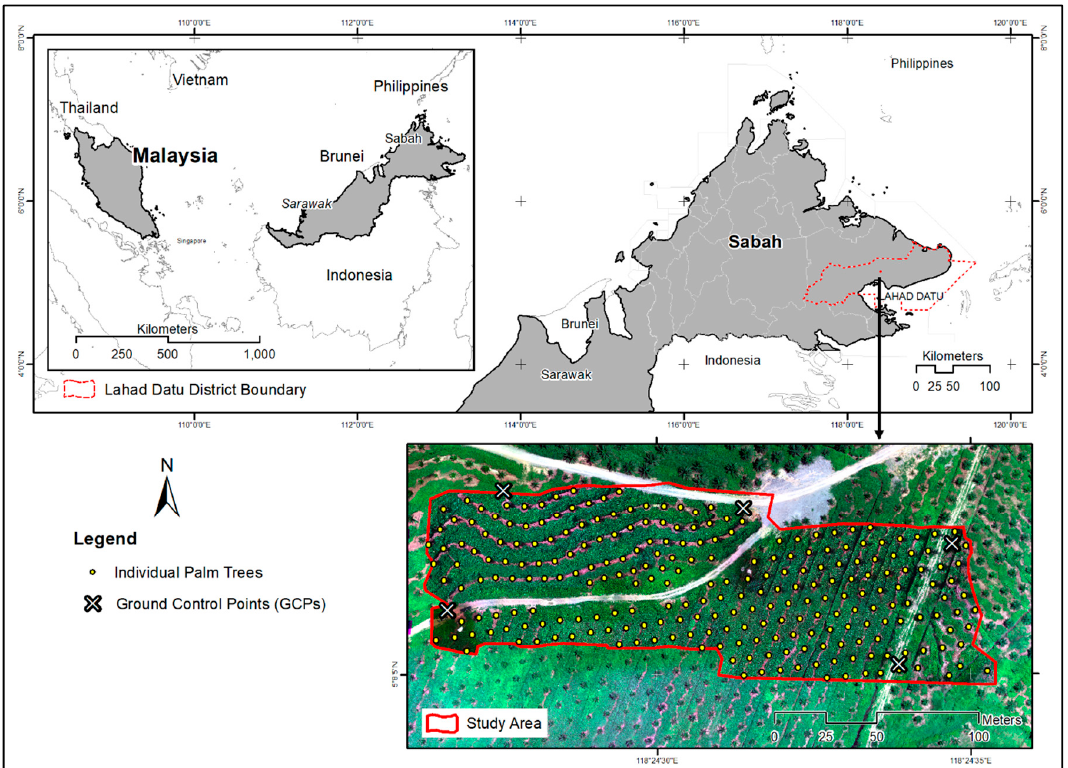
Figure 1. Location of the study area in Lahad Datu, Sabah, Malaysian Borneo.